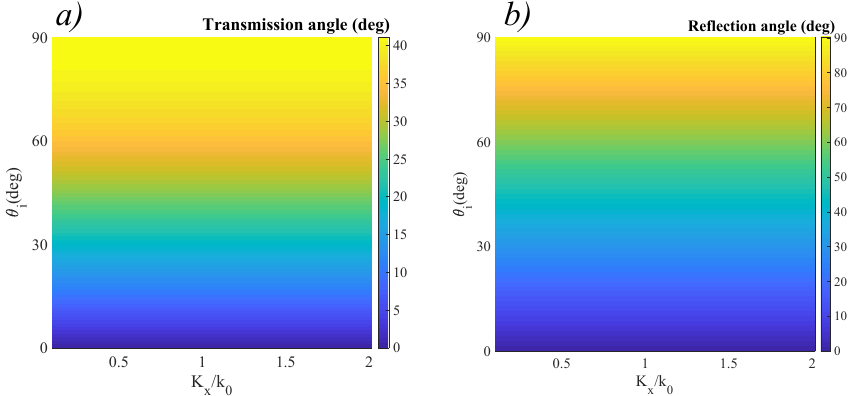
Figure 3. ( a ) Transmission angle θ t , and ( b ) reflection angle θ r obtained for a zero-gradient meta- surface in the air-to-glass incidence scenario ( n t (cid:39) 1.52). The gradient is included both to show there is no influence of the interface on the working wavelength, and to serve as a reference for the other